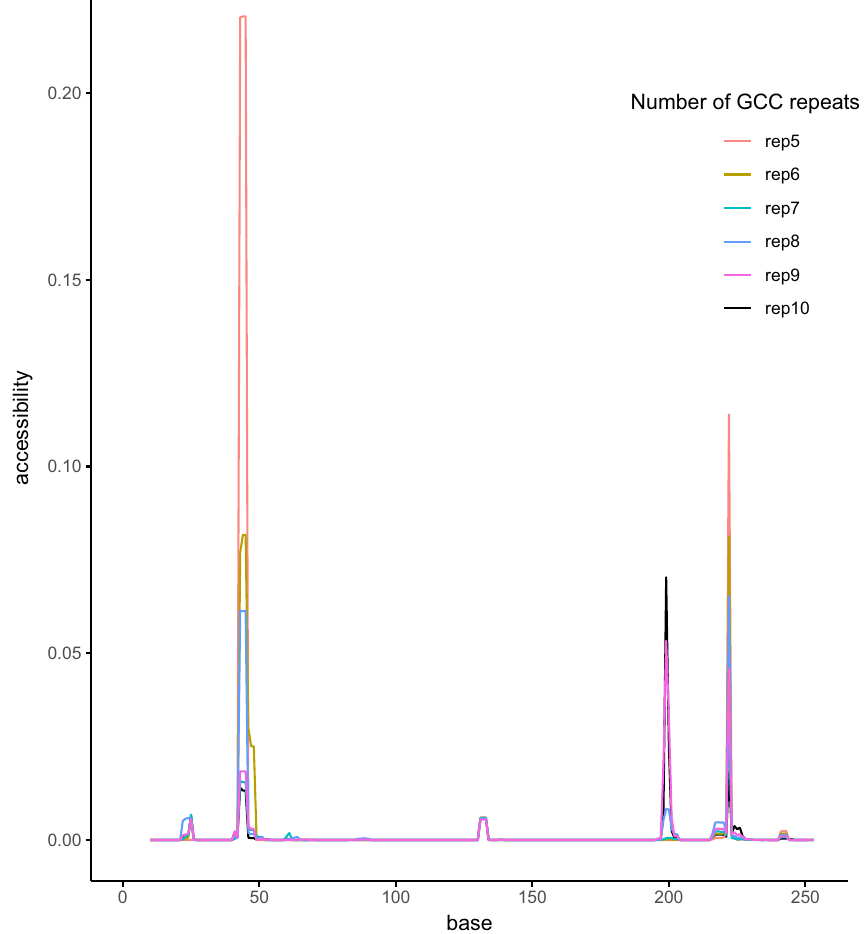
Figure 4. Accessibility (probability of being unpaired) of all regions of 10 nt length, ending at base x for the first exon of human SBF1 with 5 to 10-repeats. Differences in 3 regions were detected, at about nt 50, about nt 200, and about nt 220.